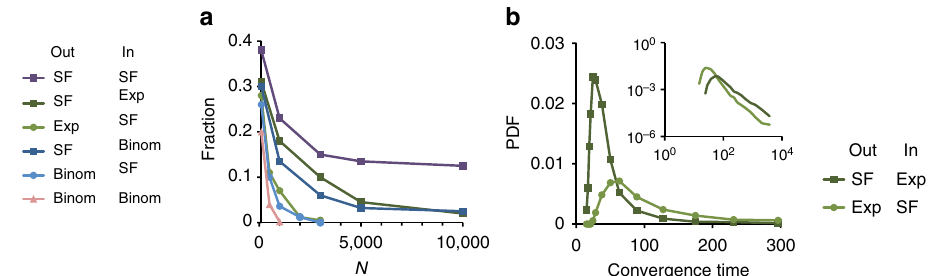
Figure 7 | Fixed points in the absence of exploration for different topological ensembles. ( a ) Fraction of networks within an ensemble which relaxed to a fixed point under the nonlinear dynamics of equation (1), with fixed connections, no constraint and no feedback. Topological ensembles which exhibited higher success in exploratory adaptation in Fig. 2b, relaxed to fixed points in a larger fraction of simulations. ( b ) Distribution of relaxation times to fixed points for two of the ensembles. Note the shorter typical timescale for the SF-Exp ensemble (the more successfully adapting ensemble). N ¼ 1,000, g 0 ¼ 10. Dergree distribution parameters: SF, ( a ¼ 1, g ¼ 2.4); Binom, p ’ 3 : 5 ; N (cid:2) (cid:3) ; Exp, ( b ¼ 3 N